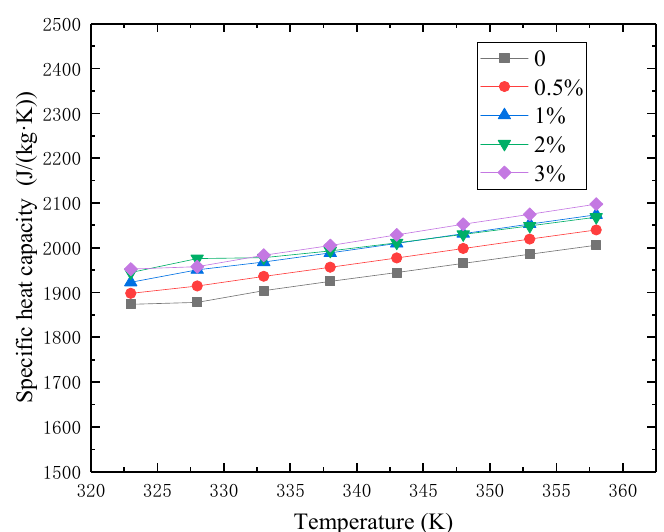
Figure 7. Specific heat capacity of prepared nanofluid samples at different temperature.